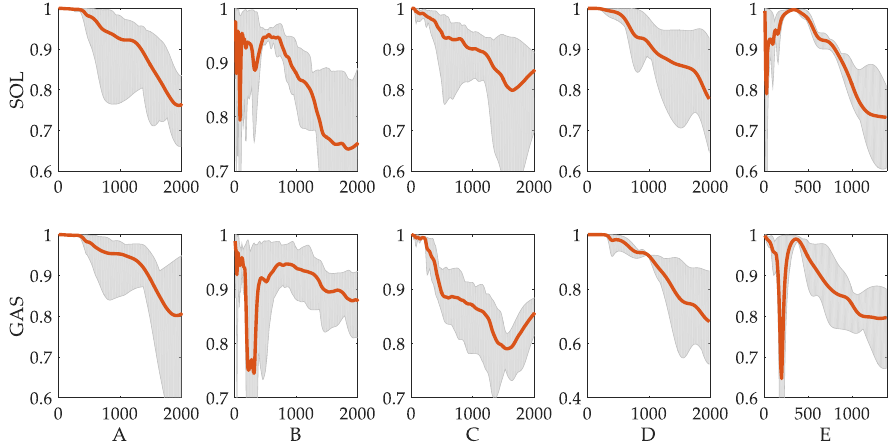
Figure 7. VAF values of reflex prediction results. Each column represents one subject. The red lines are the mean values of six trials. The gray areas represent maximum and minimum values.